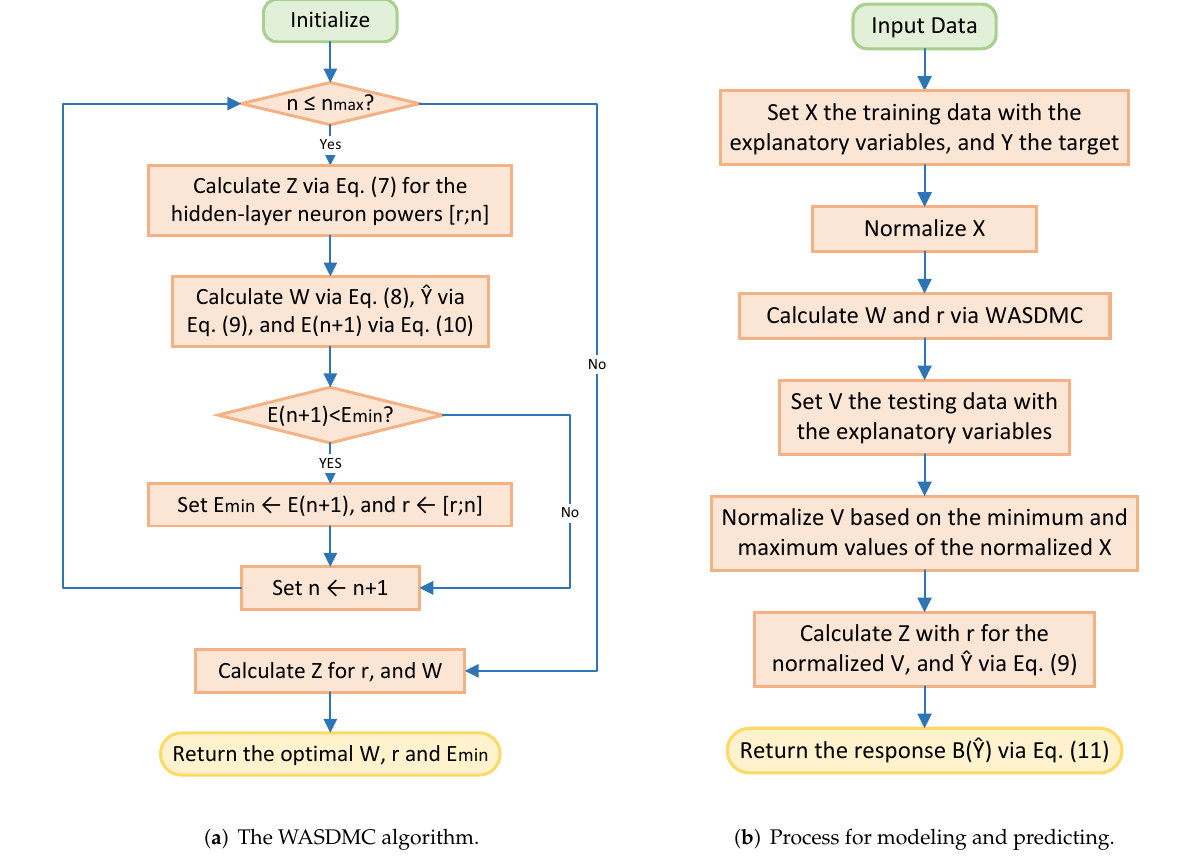
Figure 2. The WASDMC algorithm and the process for modeling and predicting with the WASDMC-based neural network model.